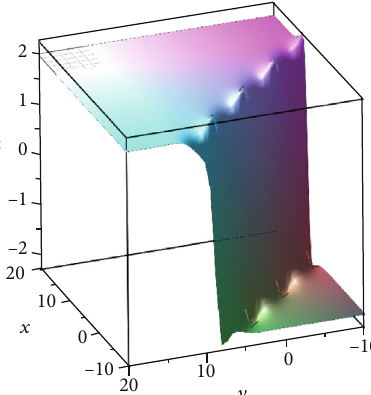
Figure 1: Spatiotemporal structure of solution (8) with the parameter selections a 1 = 1 , a 2 = 1 , a 3 = 1 , a 6 = 1 , k 1 = 1 , δ 1 = 1 , δ 2 = 1 , δ = 1 , and δ = 1 5 6